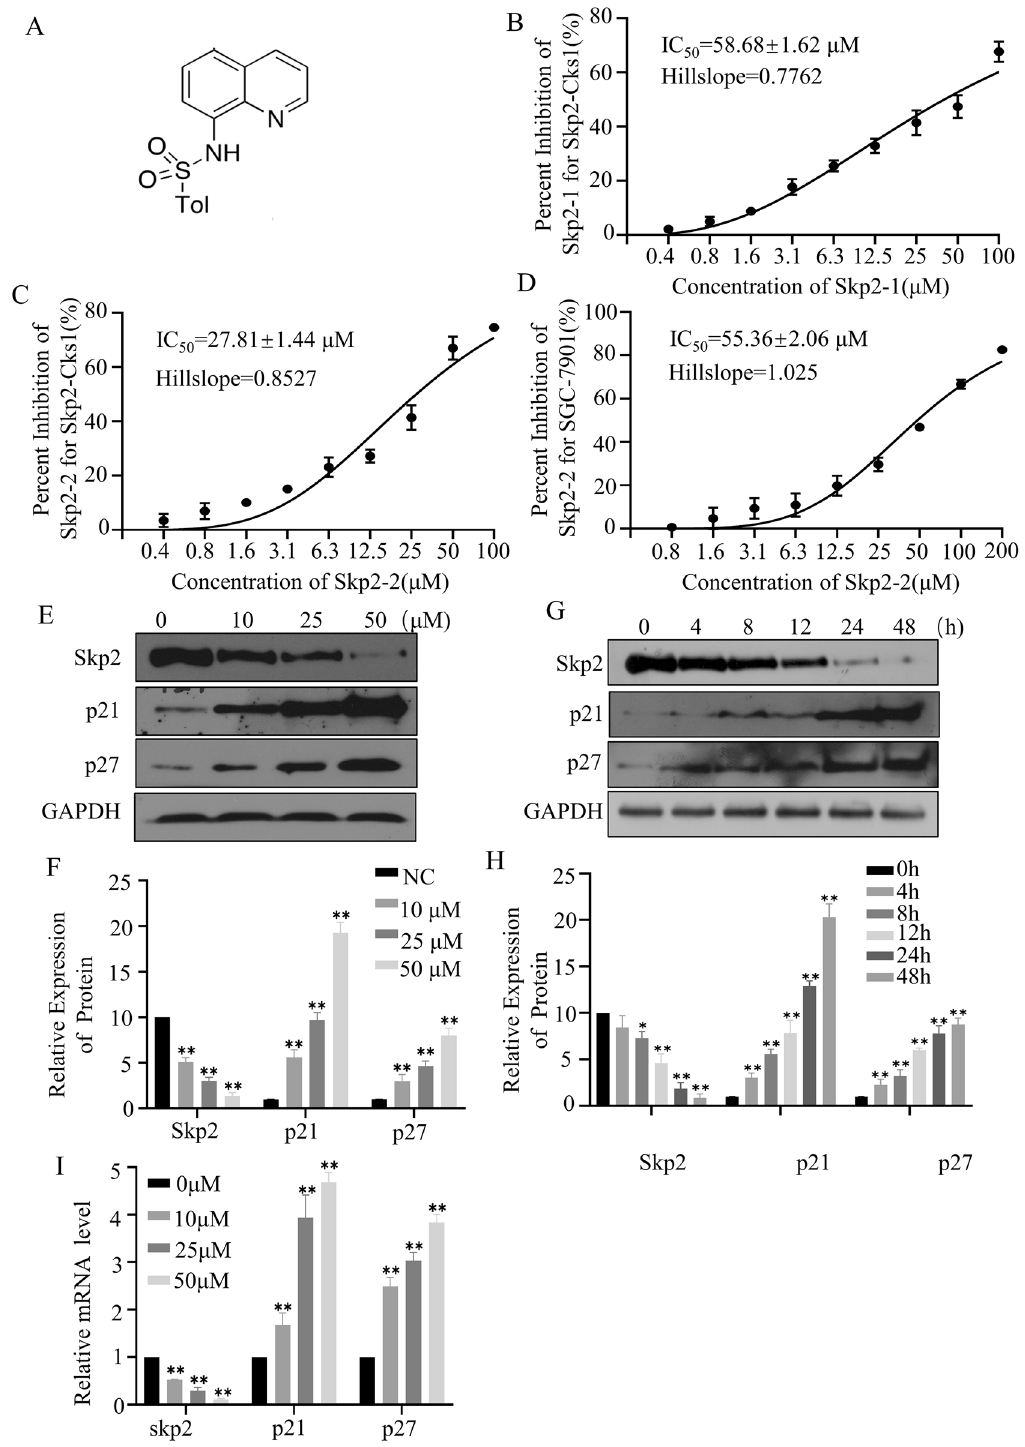
Figure 4. Skp2-2 inhibits biochemical pathways in SGC-7901. ( A ) The chemical structure of compound Skp2- 2. ( B , C ) The percent inhibition of the compound Skp2-1 and Skp2-2 at various concentrations in Skp2-Cks1. ( D ) The percent inhibition of the compound Skp2-2 at various concentrations in SGC-7901. ( E , F ) SGC-7901 cells treated with increasing concentrations of Skp2-2 for 48 h. ( G , H ) SGC-7901 cells treated with 50 μM Skp2-2 for 0–48 h. The cell lysates were collected for Western blotting with the indicated antibodies. ( I ) SGC-7901cells were treated with increasing concentrations of Skp2-2 for 48 h and the changes of Skp2, p21, and p27 in mRNA level were detected by RT-PCR. The representative data of at least three independent experiments are shown, * P < 0.05, ** P < 0.01. compared with the control group (mean ± SD, n =